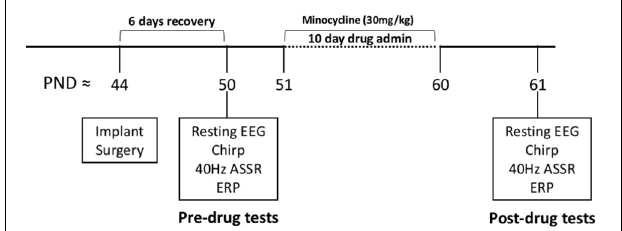
FIGURE 1 | Overview of experimental procedures. All experiments were conducted on adult male C57BL/6 mice. After surgical implantation of electrodes, mice were given 6 full days to recover before EEG experiments. All mice were recorded on all EEG protocols pre-drug administration. A total of 23 Fmr1 KO mice and 21 WT mice were tested in “pre” group before any drug administration. The mice then received either minocycline (12 KO and 9 WT) or vehicle (11 KO and 12 WT) solution through oral gavage daily for 10 days followed by “post” tests. EEG recordings were never obtained on the same day that oral gavage was